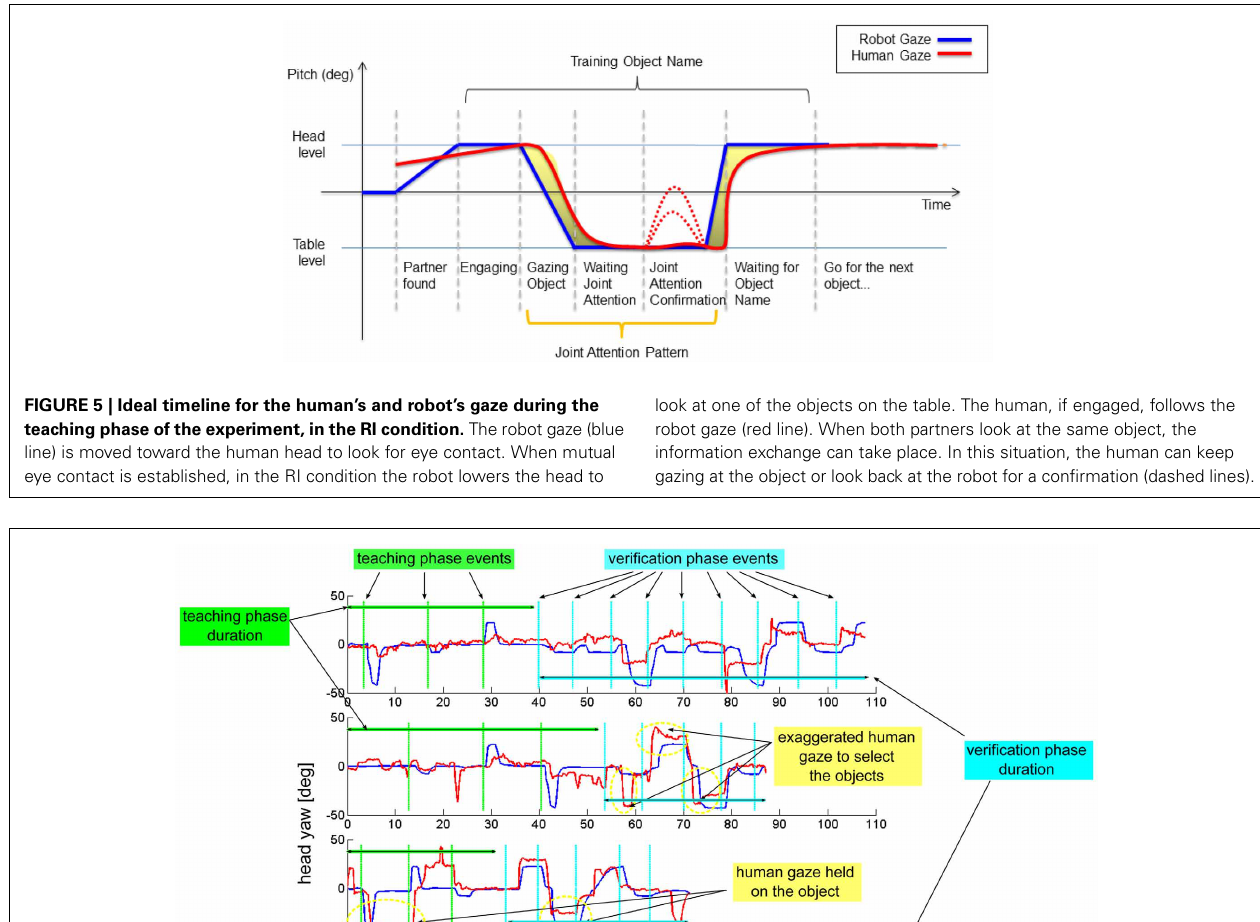
gaze behaviors in this phase. Some examples are shown in Figure 6 11 : in the first plot, the human quickly looked at the objects then came back looking at the robot; in the second, the human exaggerated the movements of his head to be more readable by the robot; in the third, the human held his gaze on the objects until he was sure that the robot had learnt its color; the 11 Inthisfigure,wereporttheplotsrelatedtoheadyaw,becausethethreelevels corresponding to the three objects are clearly visible. It is also more interest- ing with respect to plotting the head pitch, that could only show two levels (the head and table level) and would not allow to distinguish among the three objects, which are all at the same level for the head pitch.